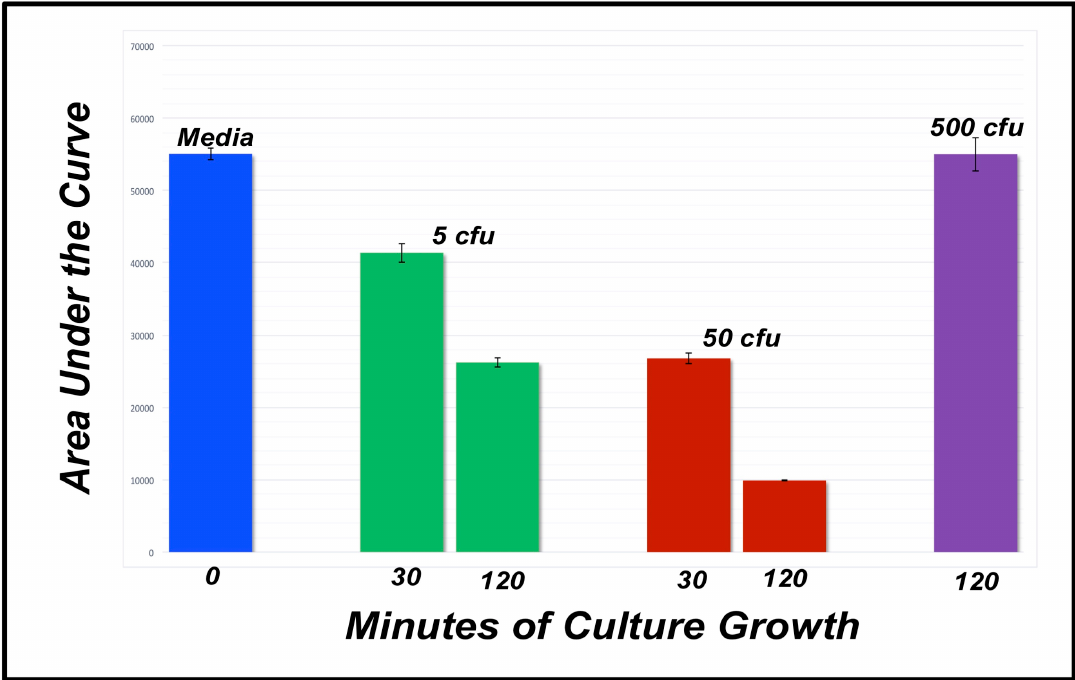
Figure 2. Rapidly detecting E. coli cells. The biosensor based on the Attenu fluorescence-quenching assay utilized rAgamOBP1 at 1 µ M as the detector element. Data were collected using a spectrophotometer. Bar graph of the areas under the response curves for the control (media, no bacteria); 5 cfu of K-12 (green); 50 cfu of K-12 (red); and 500 cfu of an E. coli strain (MG1651; Philip Rather, personal communication) without functional tryptophanase and therefore unable to produce indole (purple). The black bars are STDEV plotted with Excel and the raw data are shown in Appendix A Table